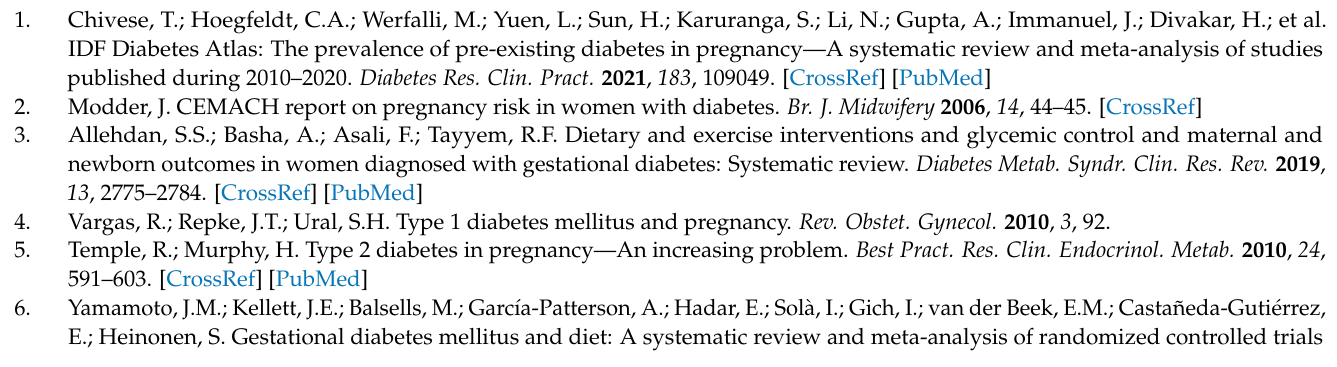
tion, Table S4: GRADE Assessment for diet-based intervention, Table S5: GRADE Assessment for exercise-based intervention, Figure S1: Funnel plot of fasting plasma glucose (mmol/L) in nutritional supplement interventions, Figure S2: Funnel plot of HOMA-IR in nutritional supplement interven- tions, Figure S3: Funnel plot of fasting plasma glucose (mmol/L) in dietary interventions, Figure S4: Funnel plot of HOMA-IR in dietary interventions, Figure S5: Funnel plot of fasting plasma glucose (mmol/L) in exercise